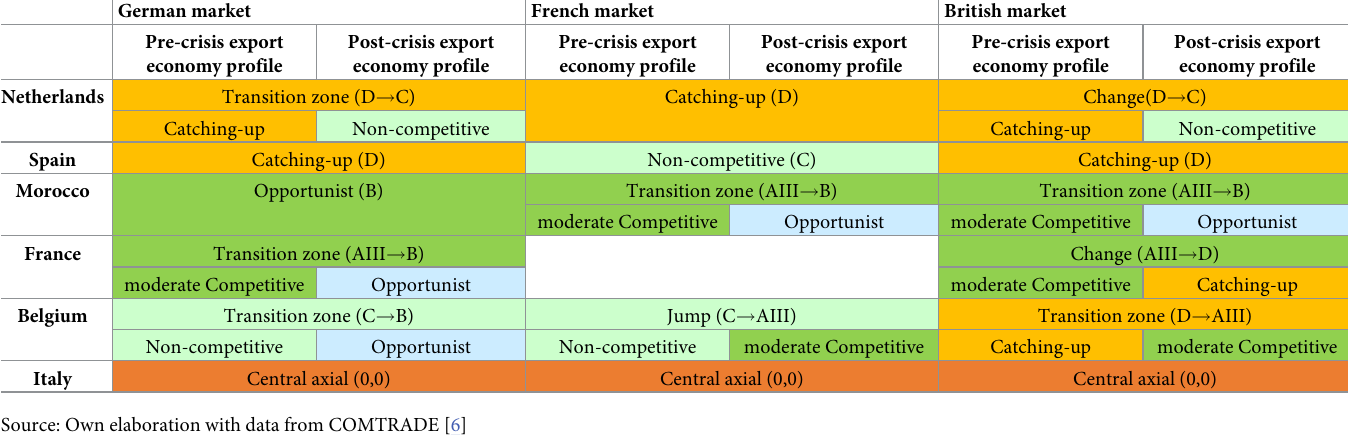
Table 2. Post-crisis export economy profile (2011–2016) for competitor economies in main European tomato